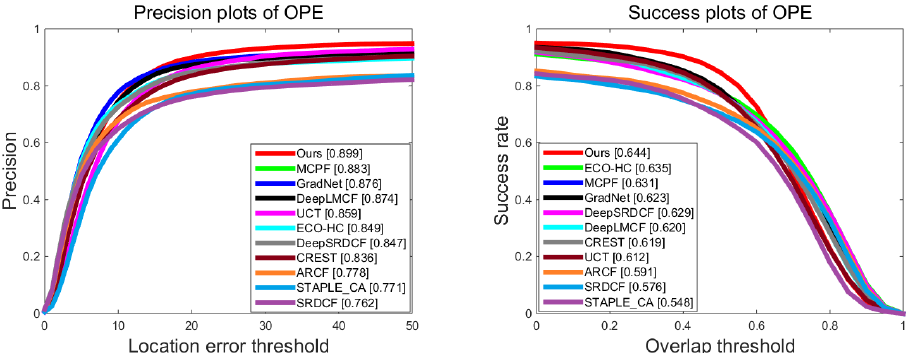
Figure 3. The overall tracking performances of precision and overlap success plots on OTB-100 dataset using OPE evaluation.